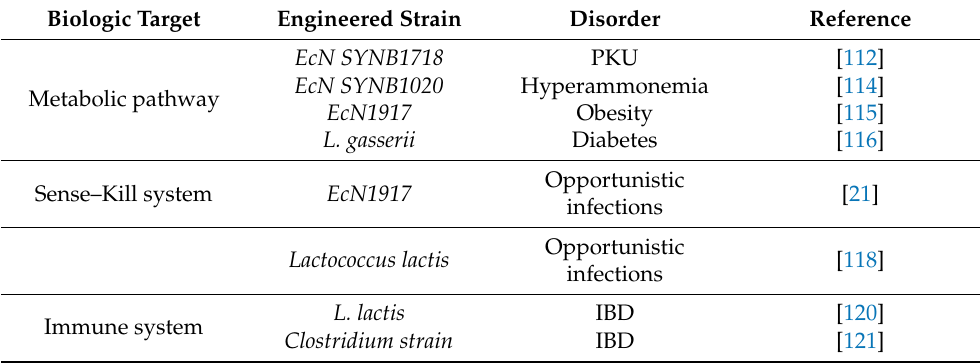
Table 1. A list of engineered bacteria used as potential therapeutic tools. The main target areas are metabolic pathways, the inhibition of colonization (sense–kill system), and